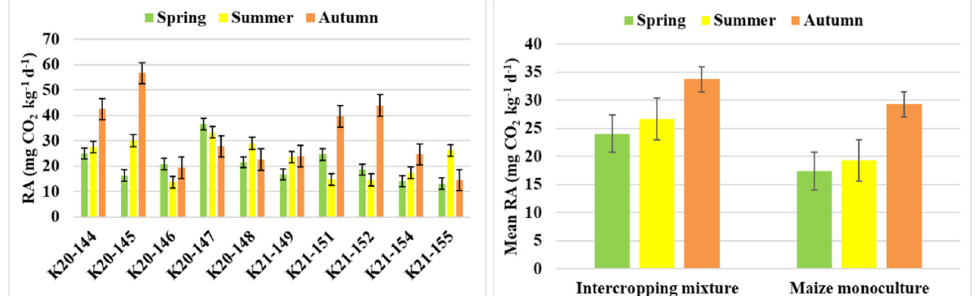
Figure 2. Respiration activity (RA) in the rasters of field K20 under the intercropping mixture and field K21 under the maize monoculture in spring, summer, and autumn.